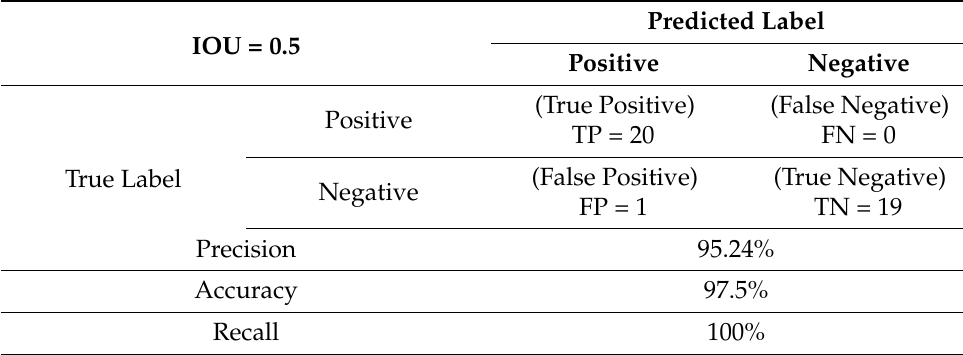
Table 7. Identification of the results obtained with the developed system. IOU =